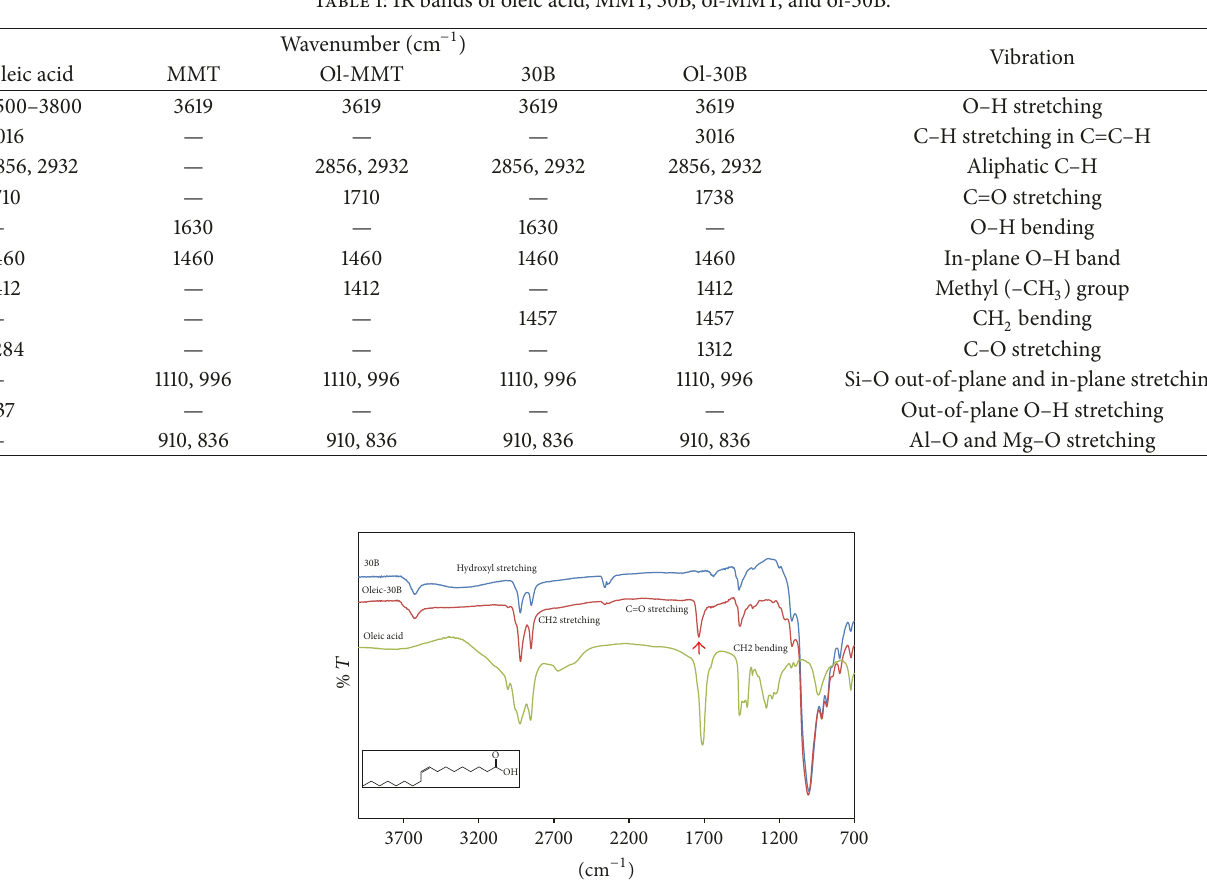
Figure 4. Commercial 30B (clay modified with methyl tallow bis-2-hydroxyethyl ammonium cations) has d -spacing of 1.88 nm. Modification of clay with oleic acid resulted in a ∘ . This corresponds to an increase shift in the (001) peak by 2.6 in d -spacing of about 2.36 nm, indicating that the oleic acid molecules are intercalated into the clay galleries. This